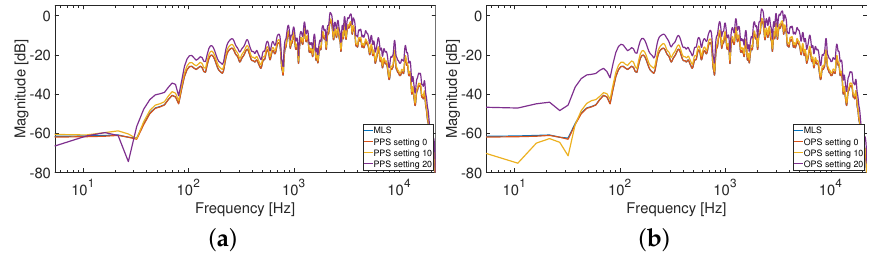
Figure 12. HRTFs measurement at driver position from the left loudspeaker to the left ear, compar- ing different distortion settings (0,10, and 20) using the Electro Harmonix East River Drive pedal. The MLS is compared to ( a ) PPS Legendre and ( b ) OPS Gaussian. A smoothing of 1/12 octave band was applied to the responses.